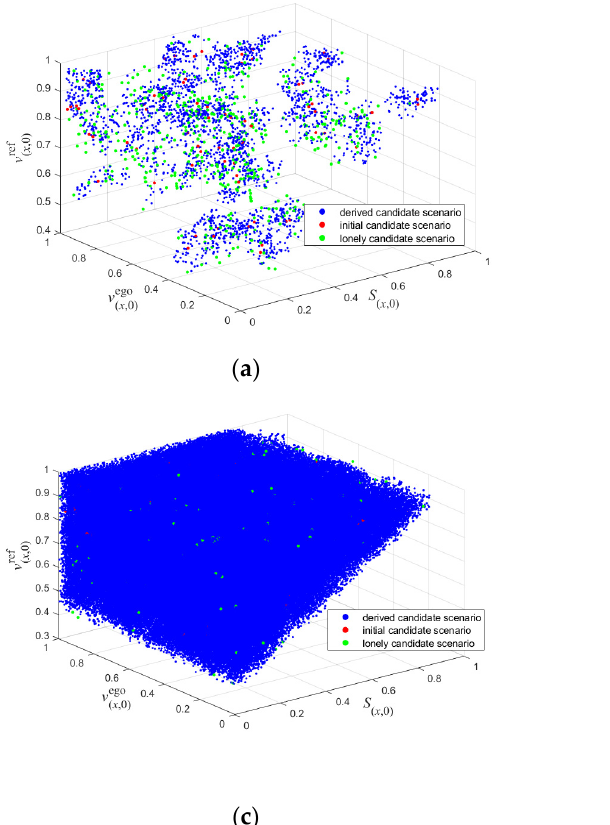
Figure 17. The distribution of distances between candidate scenarios and their nearest adverse sce- narios. 6. Conclusions Scenario-based testing is a promising method for HAV testing. Testing HAV in boundary scenarios near the performance boundary between critical and non-critical sce- narios is crucial. In this study, scenarios likely to be boundary scenarios are called